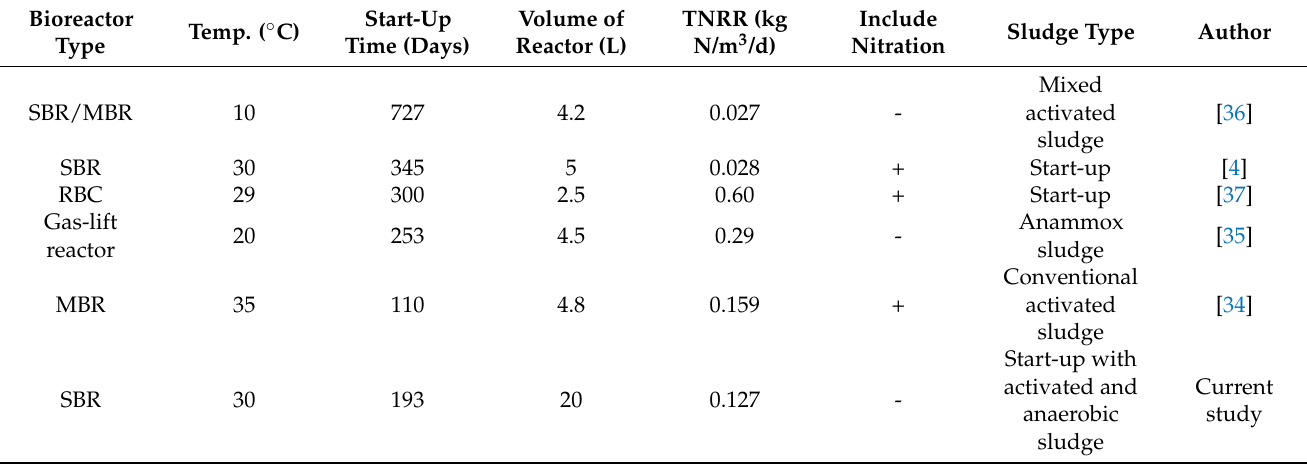
Table 2. Comparison of anammox removal rates by different sludge and reactor